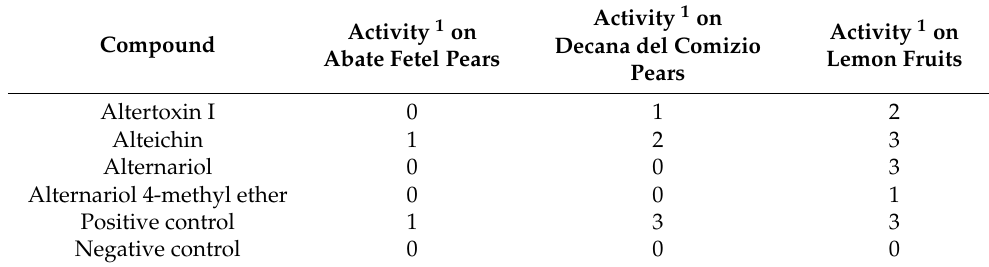
Figure 6. Necrotic effects produced by compounds 1 – 4 (tested at 5 × 10 − 3 M), the positive control epi -pyriculol (+) (tested at 5 × 10 − 3 M), and the negative control (-) (4% DMSO in distilled water), on Abate Fetel pears after 0 ( A ) and 3 ( B ) days; on Decana del Comizio pears after 0 ( C ) and 3 ( D ) days; and on lemon fruits after 0 ( E ) and 3 days ( F ). Table 3. Phytotoxic activity of compounds 1 – 4 , and positive ( epi -pyriculol) and negative controls, on pear and lemon samples after 3 days at a concentration of 5 × 10 − 3